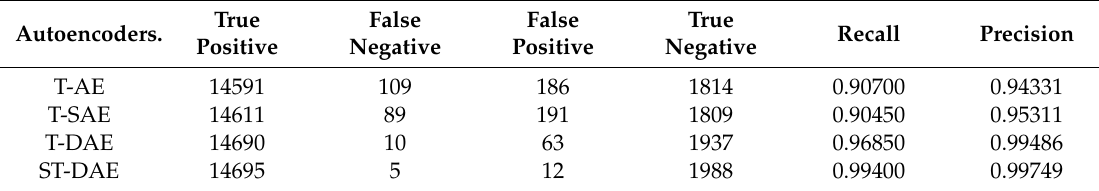
Table 3. Point anomaly detection results.